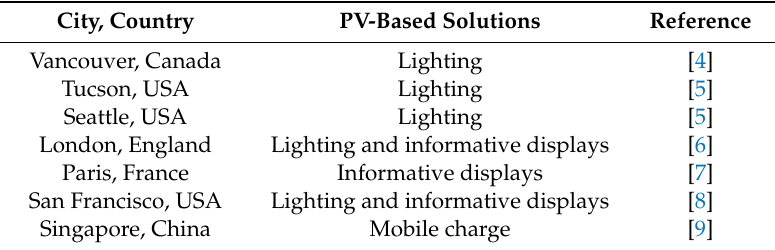
Table 1. Cities with pilot solar-powered bus